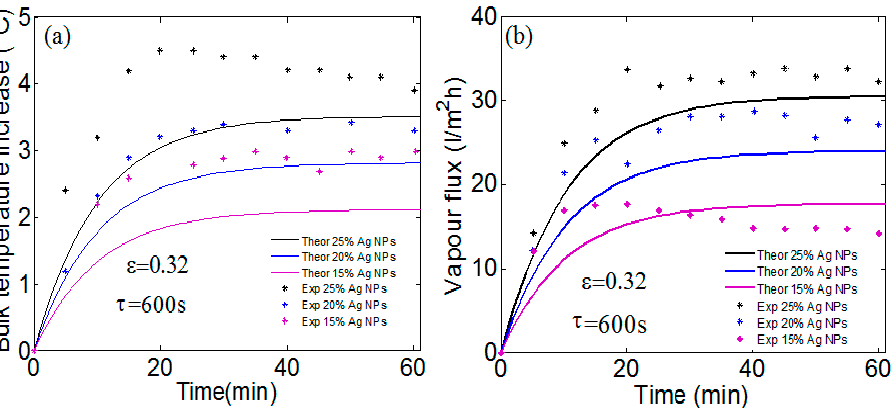
Figure 4. Theoretical calculations and measurement for a) the membrane temperature rise and b) the transmembrane vapor flux to pure water. The cooling time is obtained by fitting the measured bulk temperature increase using an exponential function. PVDF membranes loaded with 25% Ag NPs can produce vapor flux around 11-fold higher than the corresponding values for unloaded membranes.